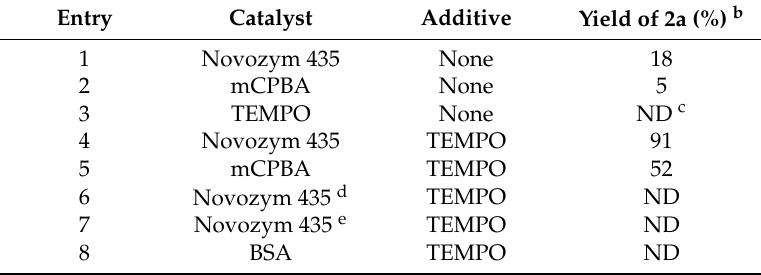
Oxidation of salicyl alcohol to salicylaldehyde catalyzed by lipase. a mCPBA: meta-chloroperoxybenzoic acid; TEMPO: 2,2,6,6-tetramethyl-1-piperidinyloxy; BSA: Bovine serum albumin.